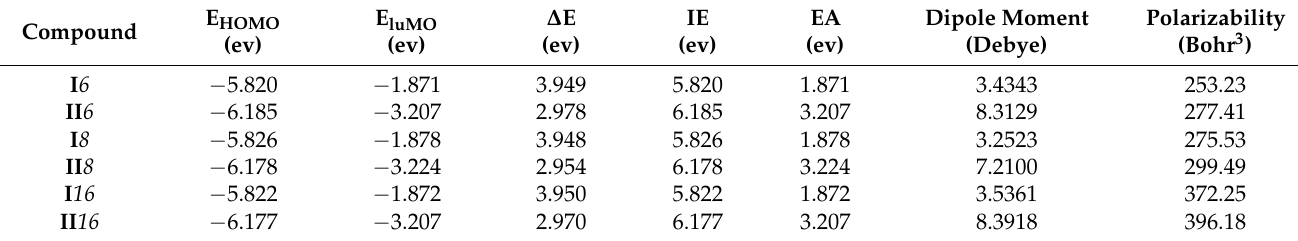
Table 3. E HOMO , E LUMO , ∆ E, the dipole moment, and the polarizability calculated using B3LYP/6-311G** method for the present groups I n and II n